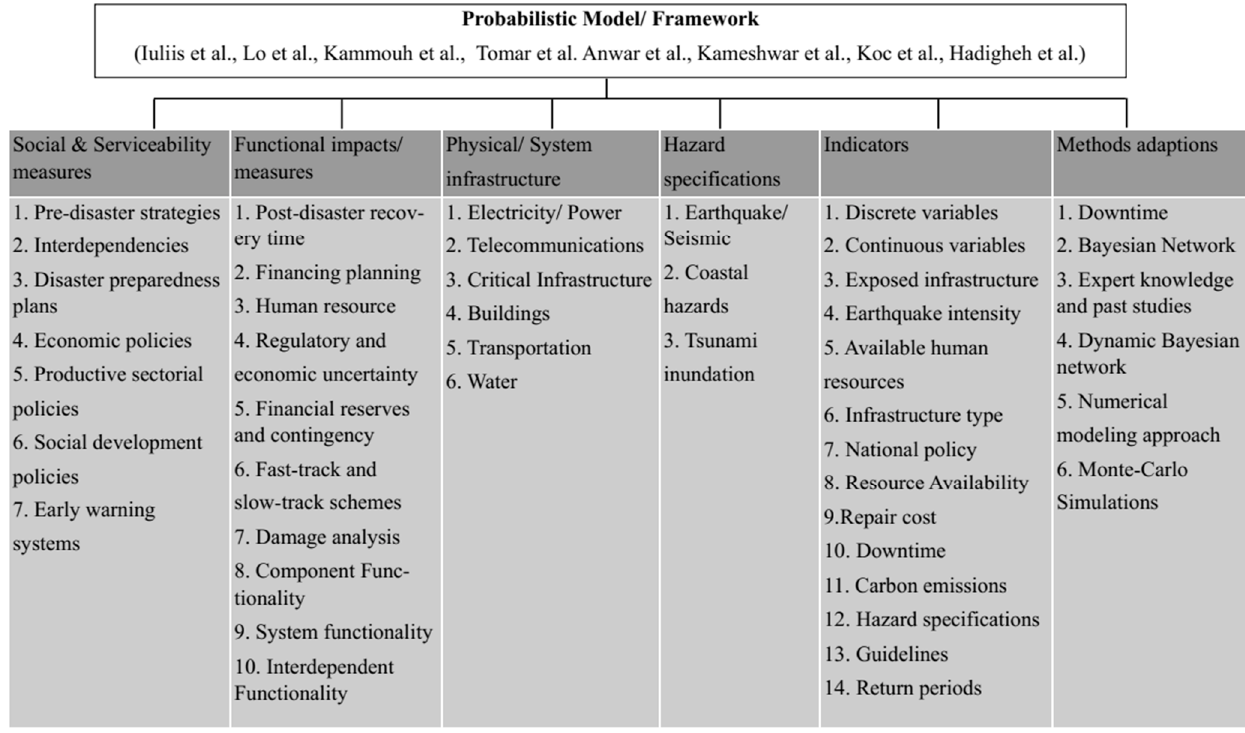
Figure 8. Attributes of the probabilistic-based framework from past studies in terms of social, functional, and physical metrics, taking into account the indicators and methodology used.